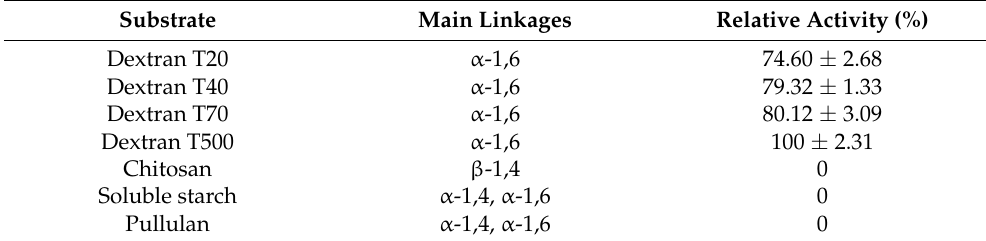
Table 1. Optimal catalytic substrate for PsDex1711.